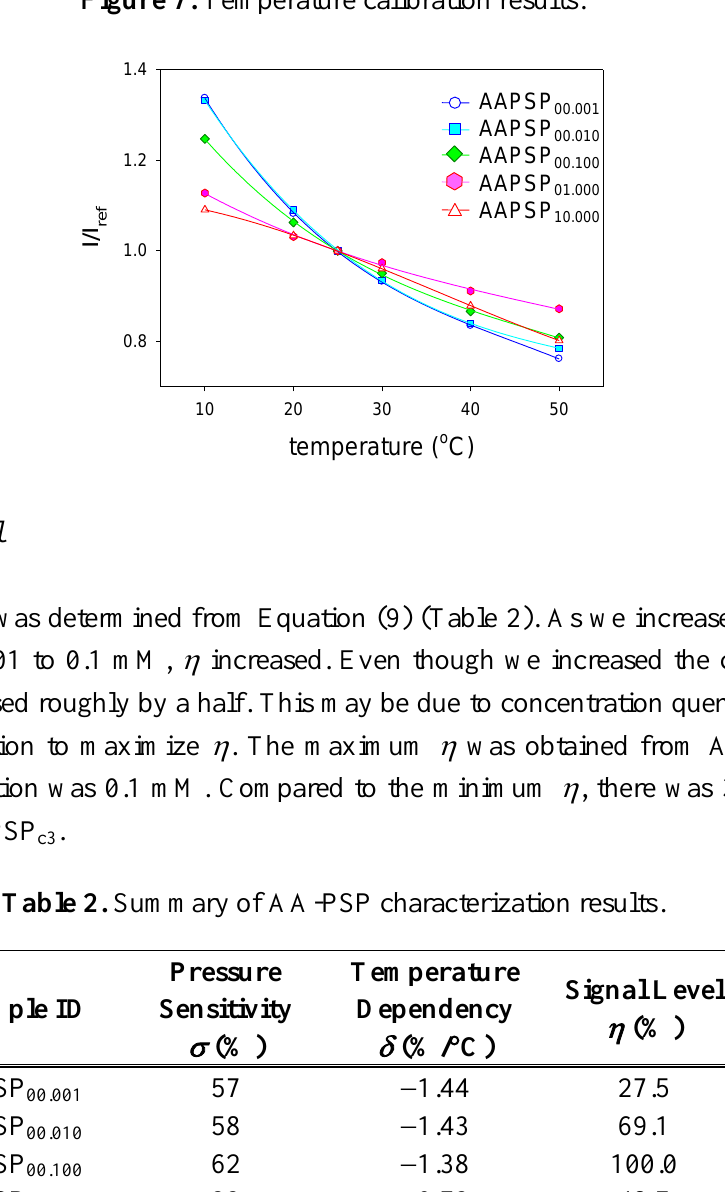
Figure 7. Temperature calibration results.